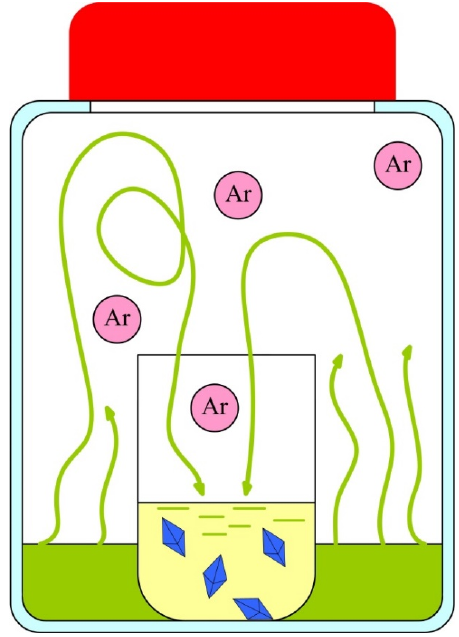
Figure 5. Crystallization in a confined space.